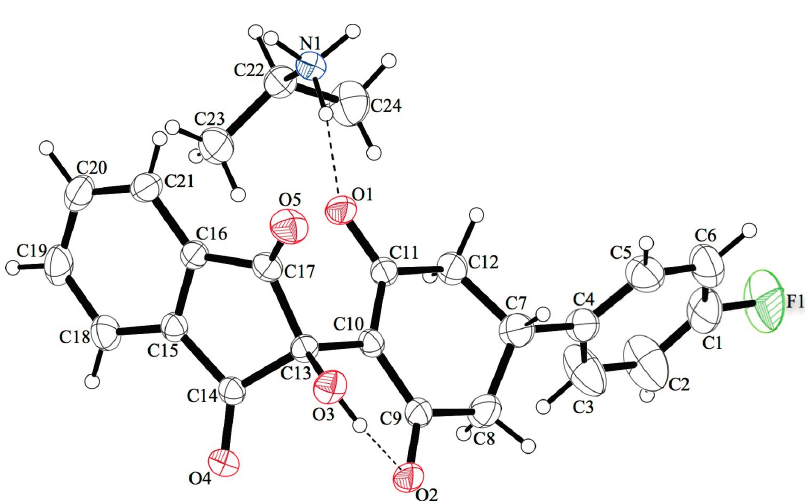
Figure 4. Crystal structure of 4d’ with our numbering scheme; displacement ellipsoids are drawn at the 30% probability level. Drawing was performed using the OLEX2 graphical interface